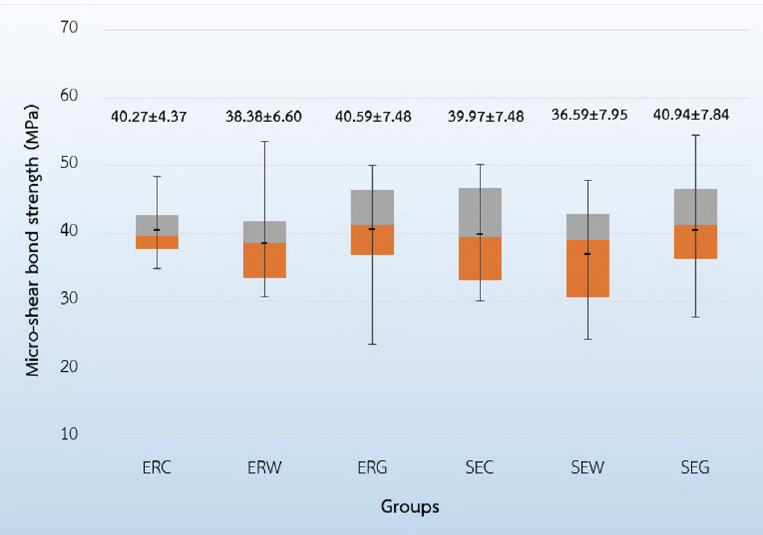
Figure 1. Micro-shear bond strength of the six specimens (MPa). Table 2. Two-way ANOVA for micro-shear bond strength (MPa) among the six groups of specimens. Sum of Mean Scheme df Squares Bonding